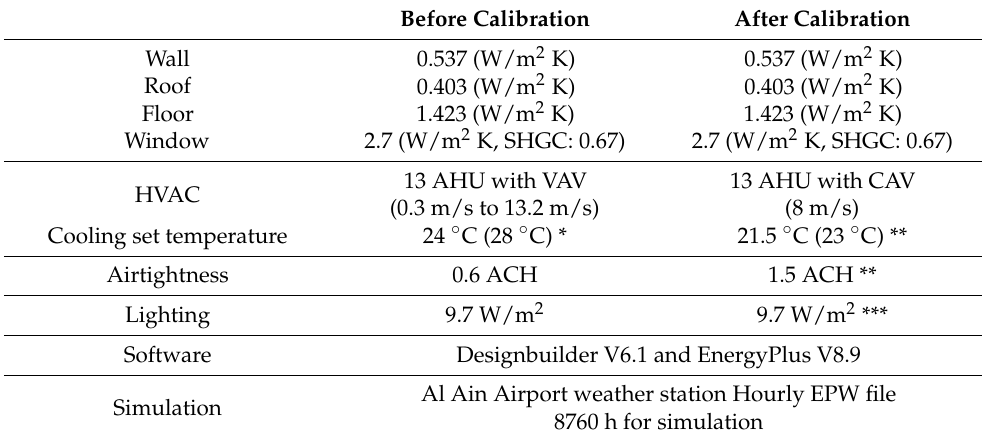
Table 5. Simulation models’ specification and input data for calibration.